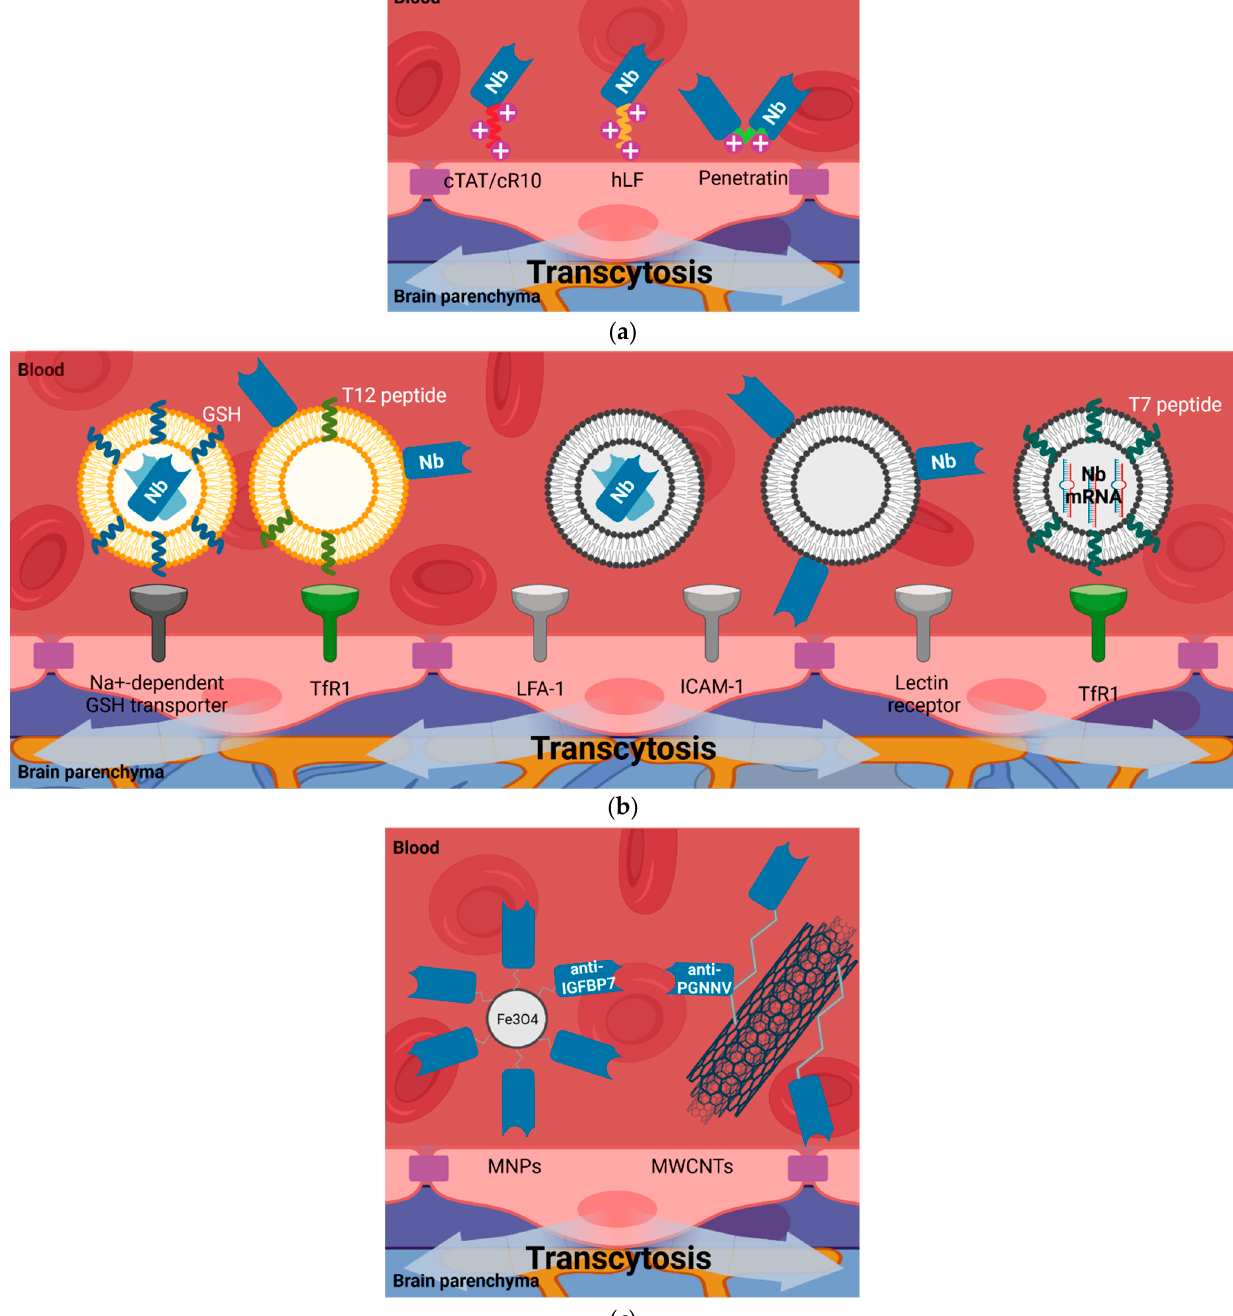
Figure 5. Nanobody BBB permeability due to shuttle-mediated transcytosis. Several molecular entities have been utilized to facilitate the delivery of single-domain antibodies (nanobodies and VNARs) through the BBB into the brain parenchyma. ( a ) Cell-penetrating peptides (CPPs) carrying nanobodies. The positive charges on their surface mediates their interaction with the cell membrane of the endothelial cells of the BBB. ( b ) Liposomes and extracellular vesicles carrying